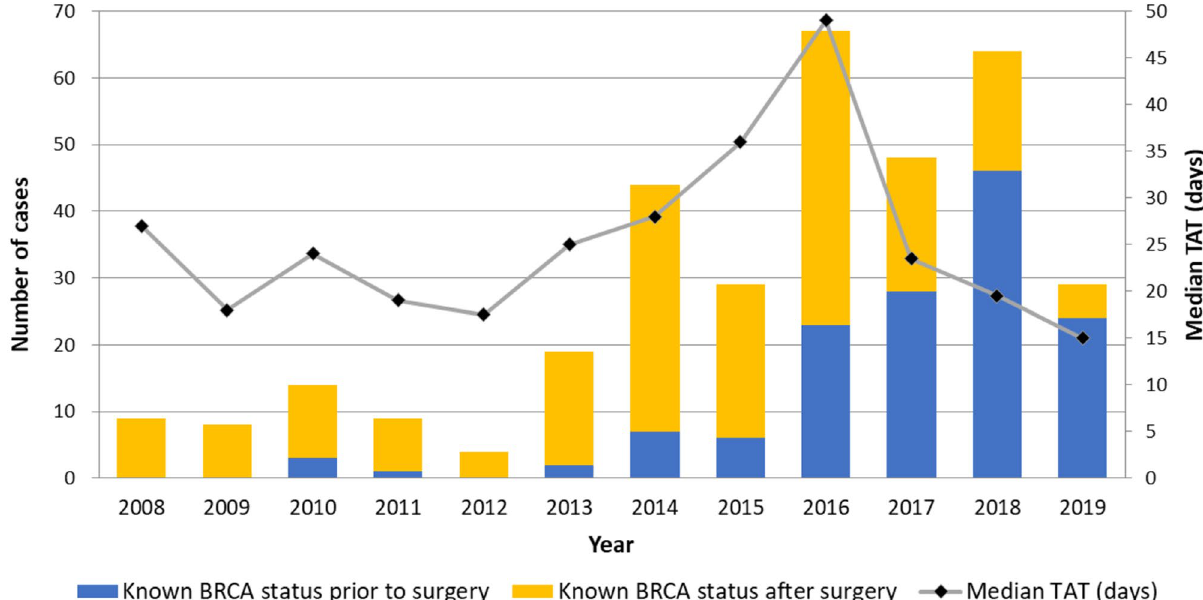
Figure 3. Bar and line graph showing number of cases tested positive for BRCA1/2 who underwent curative breast cancer surgery and median turnaround time for BRCA1/2 testing in Samsung Medical Center. TAT turnaround